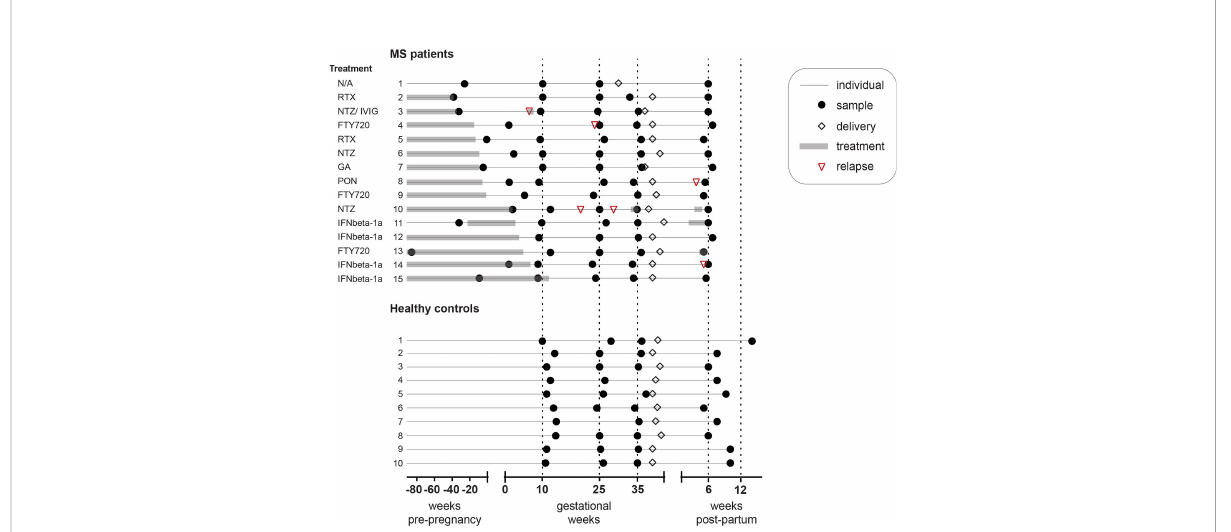
FIGURE 1 Study cohort characteristics. Schematic representation of the cohort consisting of pregnant MS patients (n = 15) and healthy controls (n = 10). Shown is the exact sampling time in weeks (black circles) for the pre-pregnancy sample (only in the MS group), as well as in the 1 st , 2 nd , and 3 rd trimesters of pregnancy and post-partum. Delivery (white rhombus), treatment duration (grey rectangle) and relapse (red triangle) are also depicted. MS patients were recruited at Karolinska University Hospital, Solna, Sweden (n = 10), at Linköping University Hospital, Linköping, Sweden (n = 4) and at Ryhov County Hospital, Jönköping, Sweden (n = 1). All healthy pregnant donors (n = 10) were recruited at Kalmar County Hospital, Kalmar, Sweden. MS patient 3 had immune globulin intravenous at gestational week 6.4, patient 10 had Natalizumab at gestational week 34.3 and week 3.7 post-partum, patient 11 had IFNbeta-1a at week 2.4-5.4 post-partum, and patient 13 had Fingolimod at week 4.9 post- partum. FTY720, Fingolimod (n = 3); GA, Glatiramer acetate (n = 1); IFNbeta-1a, Interferon beta-1a (n = 4); IVIG, Intravenous immune globulin; MS, multiple sclerosis; NTZ, Natalizumab (n = 3); PON, Ponesimod (n = 1); RTX, Rituximab (n = 2); N/A, Not applicable (n =